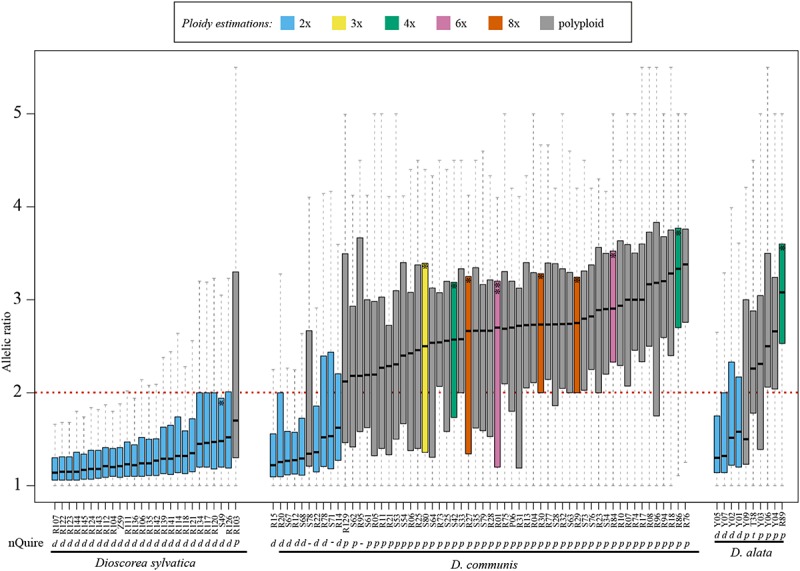
Boxplots of the allelic ratios calculated using Hyb-Seq data based on 260 low and single copy nuclear (LSCN) genes for 27 samples of Dioscorea sylvatica, 58 samples of D. communis and 10 samples for D. alata. Blue and gray colors represent the predicted ploidy level based on the median values of the allelic ratios: diploid and polyploid, respectively. The sample IDs correspond to those detailed in Supplementary Table S3 ordered by increasing median. One asterisk in a boxplot indicates samples with an estimated 1C-value (see Table 1A), while the D. communis sample with two asterisks (R01) indicates that both a 1C-value and chromosome count were performed (Table 1A). The ploidy estimations obtained from nQuire are shown below the sample IDs: d, diploid; t, triploid; p, polyploid; -, unclear (i.e., the third model determined by nQuire is tetraploid, however, our results suggest that other ploidy levels fit with this model).